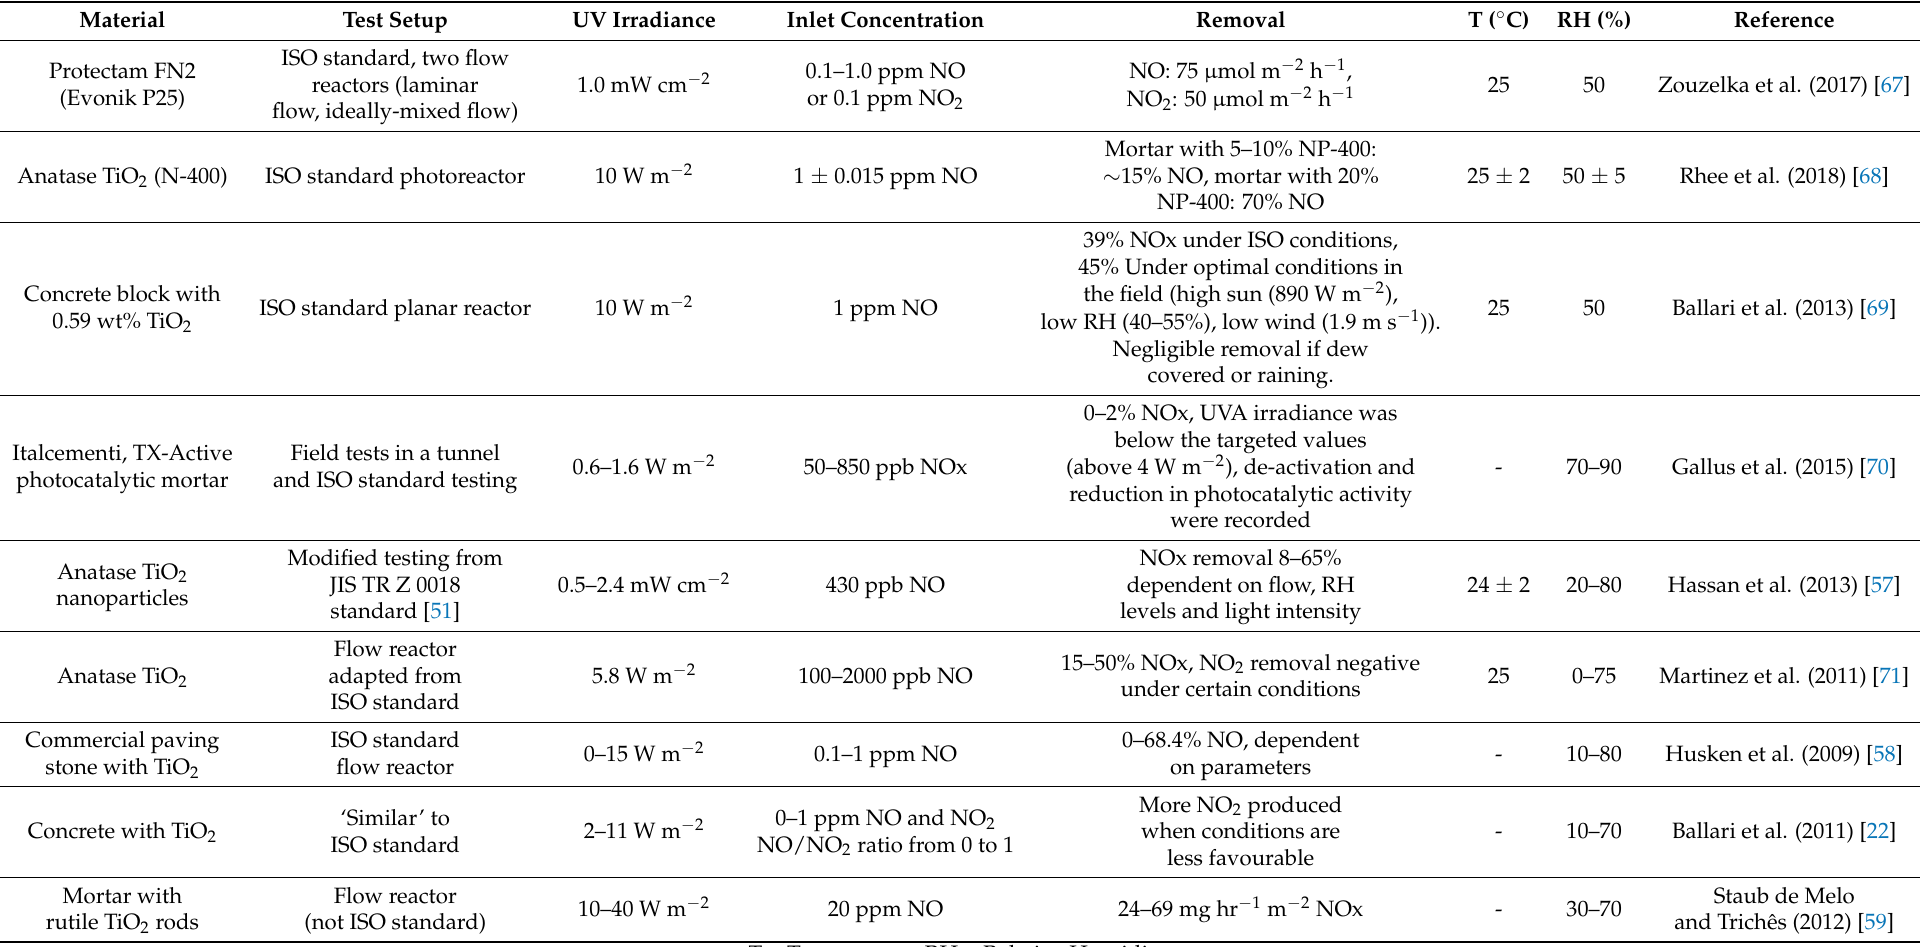
Table 1. Impact of Physical